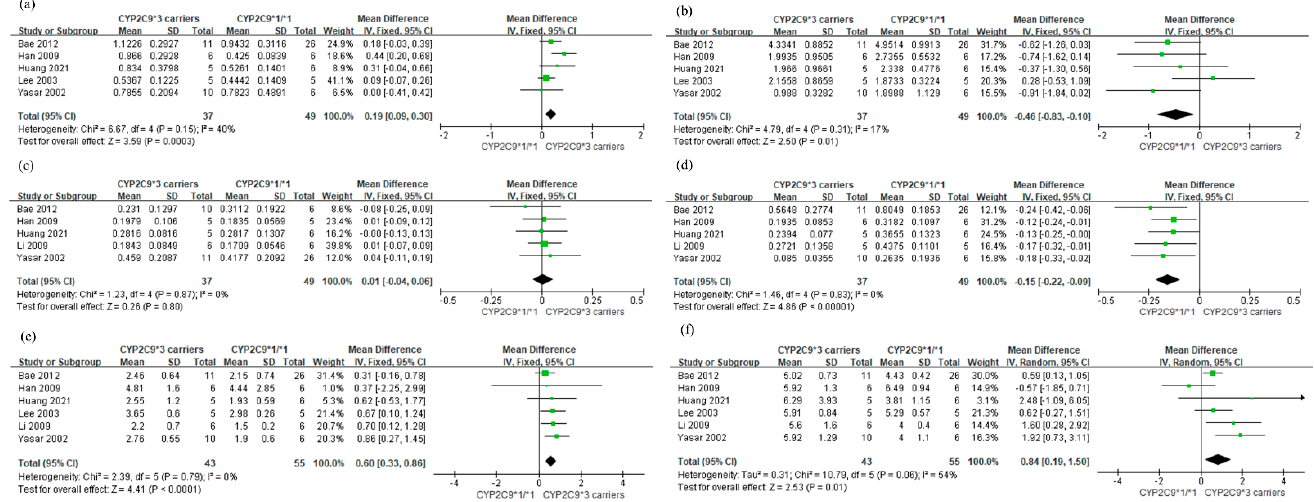
Figure 3. Forest plot comparing the mean difference between CYP2C9*3 carriers and CYP2C9*1/*1. ( a ) AUC 0- ∞ of losartan ( μg ∙ h/mL ), ( b ) AUC 0- ∞ of E-3174 ( μg ∙ h/mL ), ( c ) C max of losartan ( μg/mL ), ( d ) C max of E-3174 ( μg/mL ), ( e ) half-life of losartan (h), ( f ) half-life of E-3174 (h).